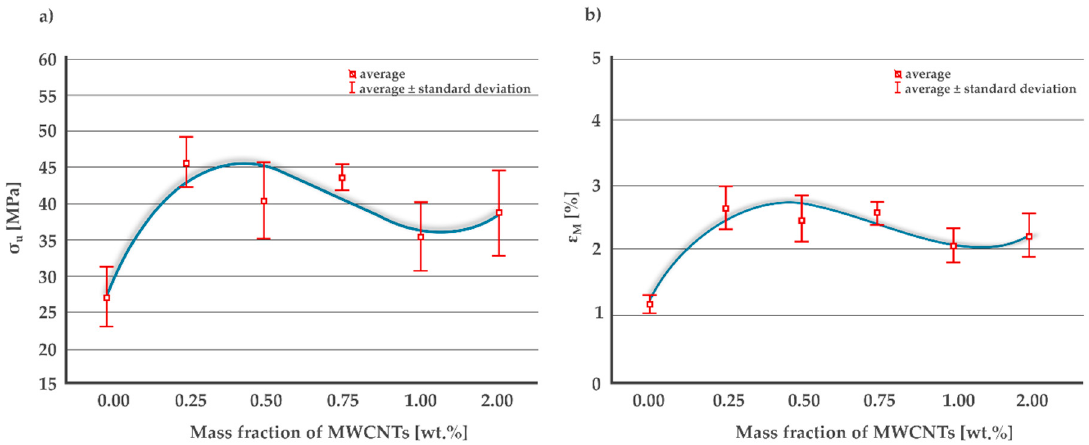
Figure 7. ( a ) Ultimate tensile strength and ( b ) nominal strain at break of the MWCNTs/epoxy composite for different MWCNTs mass fractions.